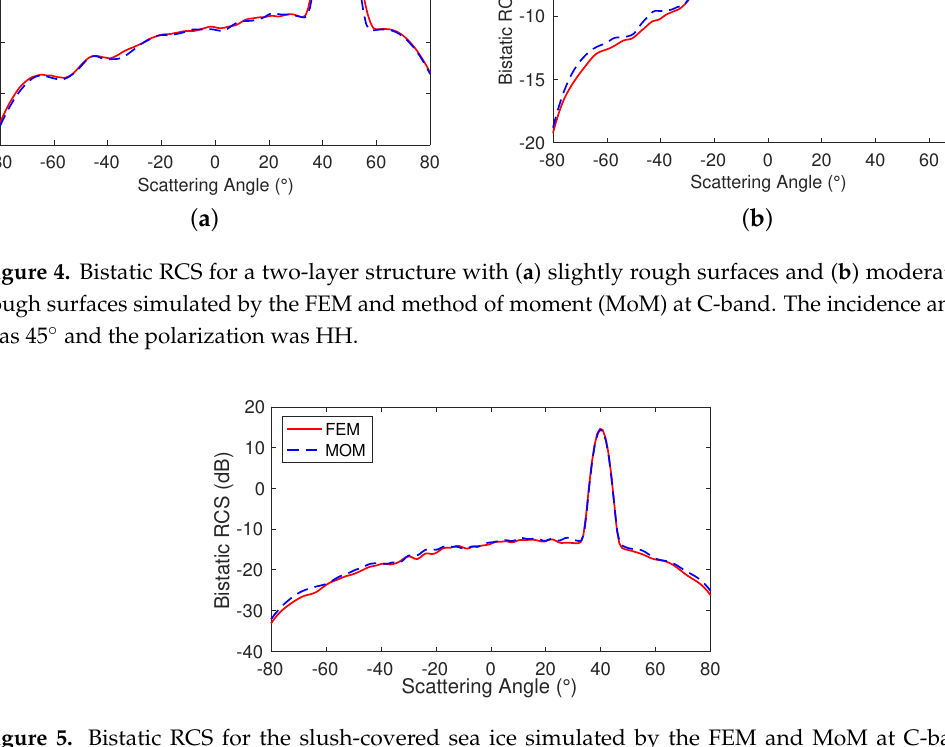
Figure 5. Bistatic RCS for the slush-covered sea ice simulated by the FEM and MoM at C-band. The incidence angle was 40 ◦ and the polarization was